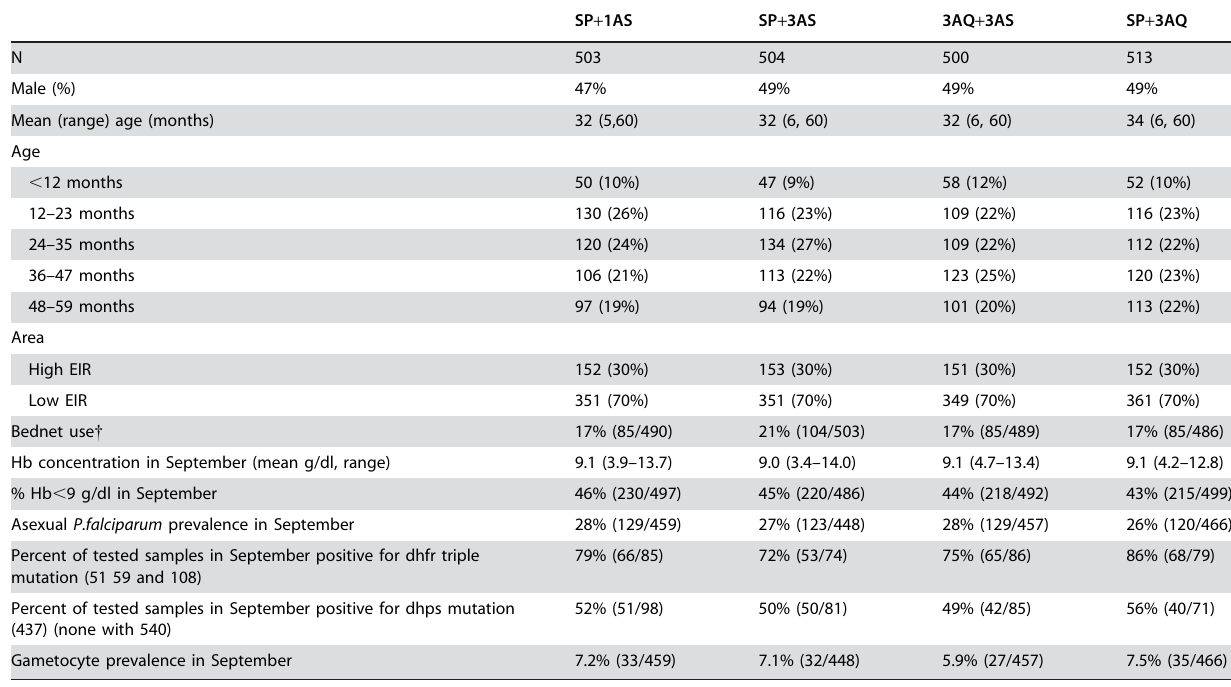
Table 1. Characteristics of the study subjects at enrolment by treatment group. .. ... .... ... ... .... ... ... .... ... ... .... ... ... .... ... ... .... ... ... .... ... ... .... ... ... .... ... ... .... ... ... .... ... ... .... ... ... .... ... ... .... ... ... .